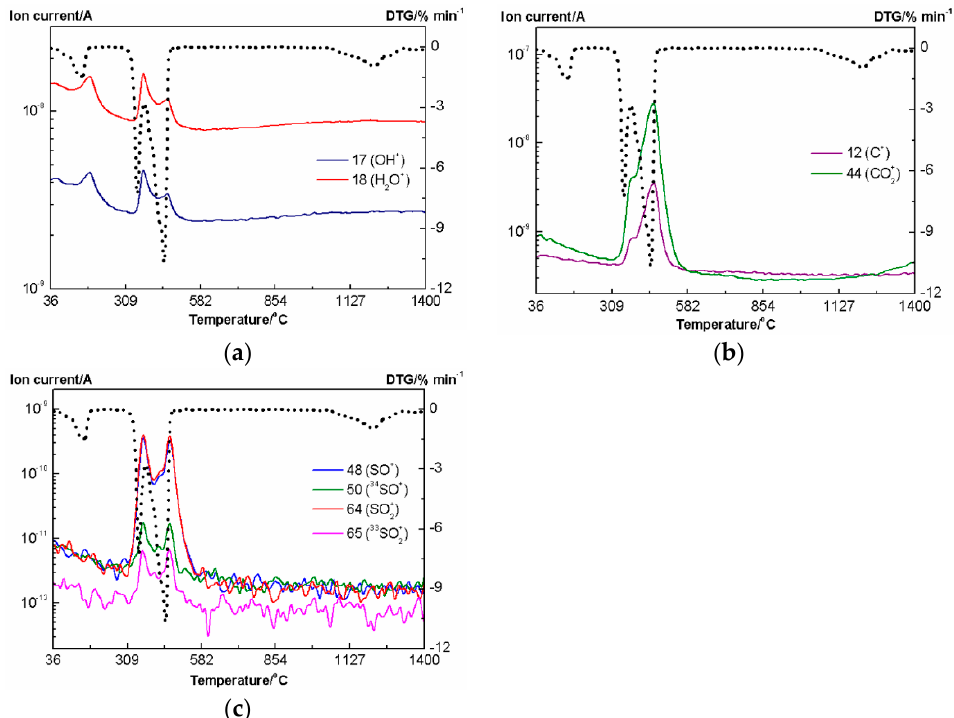
Figure 5. The ionic masses of gaseous products released during the thermal decomposition of 1 in helium and the corresponding ionic current tracks (the solid line) and a DTG run (the dotted line) related to the evolution of water ( a ), carbon oxides ( b ), sulfur dioxide ( c ) or selected species ( d ) .